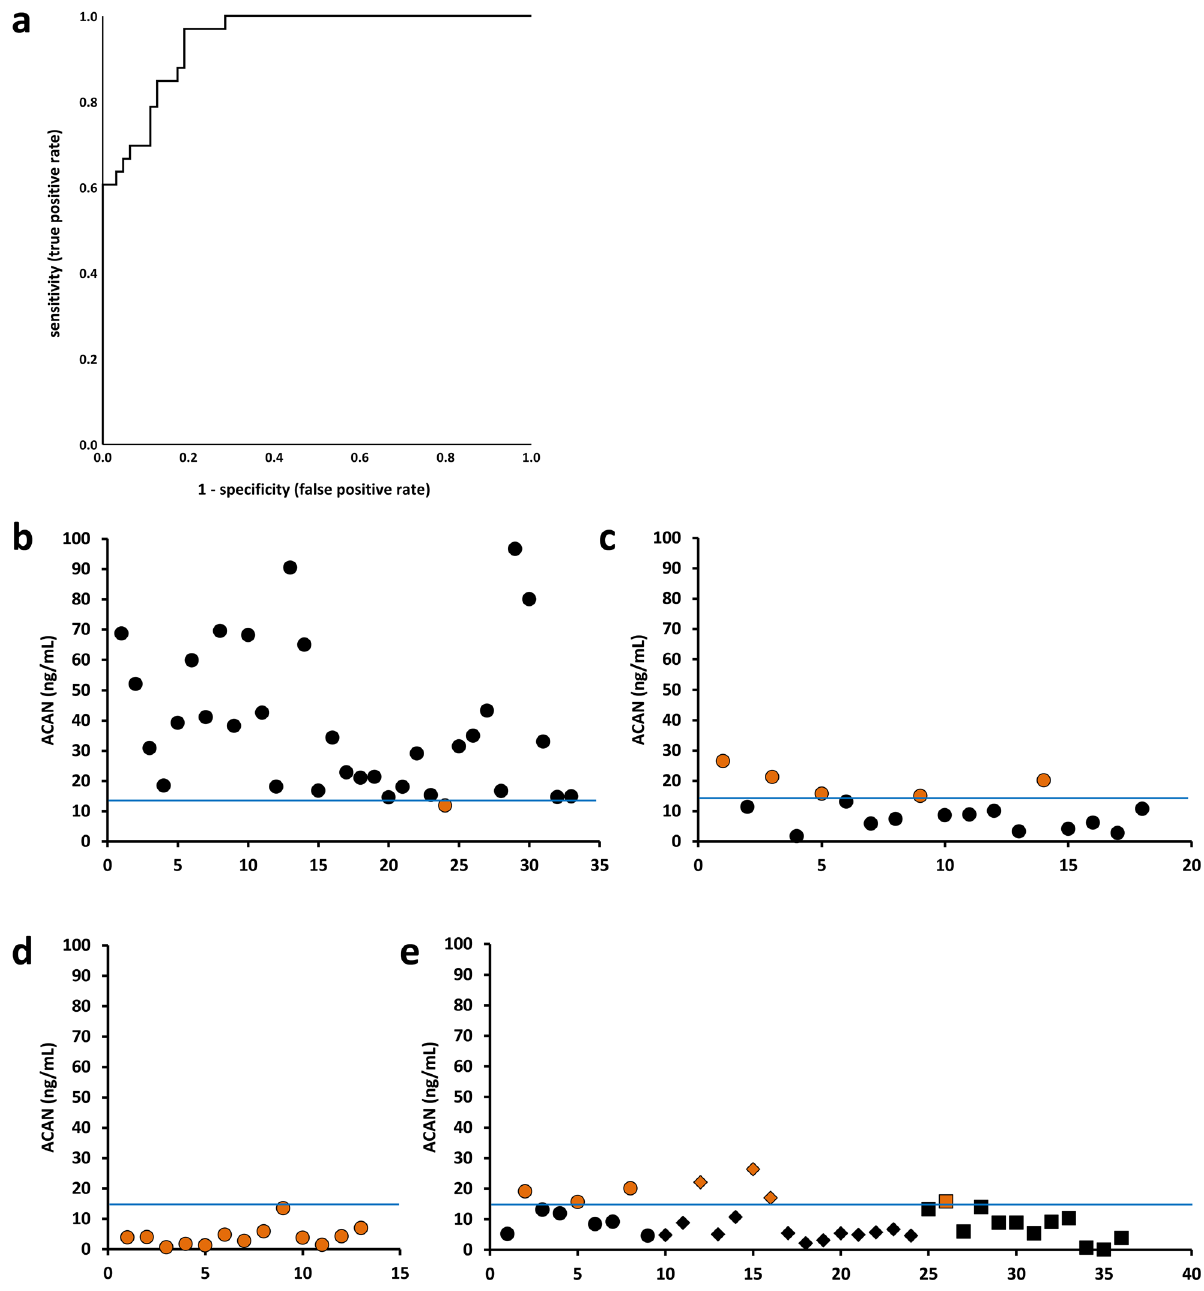
Figure 7. Sensitivity and specificity of ACAN to detect ATAAD. (a) Receiver-operating characteristics curve for all patients with ATAAD (n = 33) vs. all control subjects (n = 63). (b) ACAN levels in ATAAD patients (n = 33). (c) ACAN levels in STEMI patients (n = 18). (d) ACAN levels in patients with aneurysm (n = 13). (E) ACAN levels in surgical controls (MVR) (filled circle, n = 9), cardiac controls (N-CAD) (filled diamond, n = 15) and healthy persons (filled rectangle, n = 12). The blue line refers to the optimum discrimination level determined by the ROC analysis. Wrongly grouped samples are indicated in orange. ACAN Aggrecan, ATAAD acute thoracic aortic dissection, MVR mitral valve repair, N-CAD no coronary artery disease, ROC receiver-operator-curve, STEMI